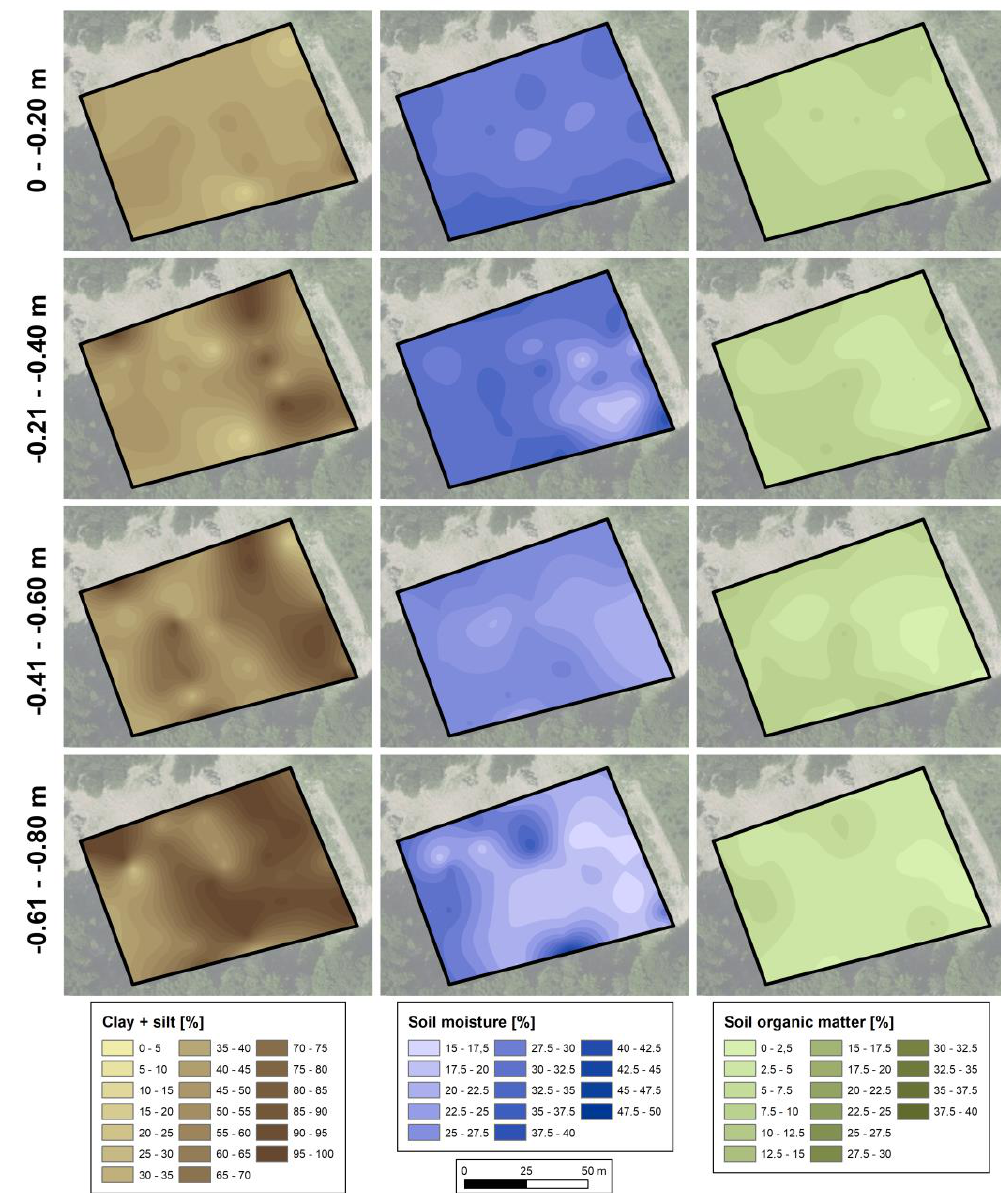
Figure 13. Interpolated soil characteristics, CUT EX. Aerial photography provided by LVermGeo RLP (2019).